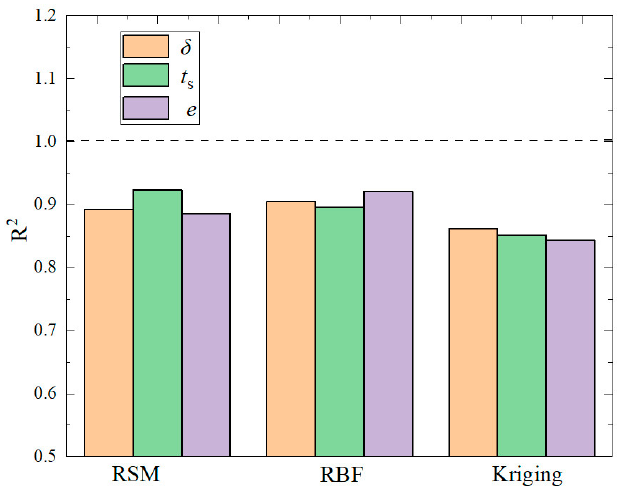
Figure 17. R 2 value of RSM, RBF, and Kriging surrogate models. Table 2. Single surrogate model weight coefficients.